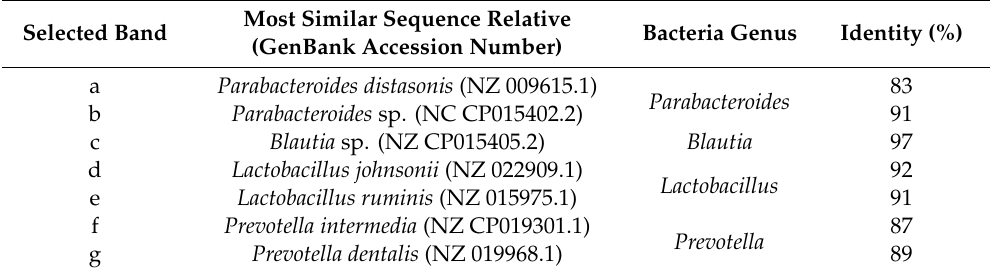
Table 1. Sequences of bands a–g based on the BLAST database.